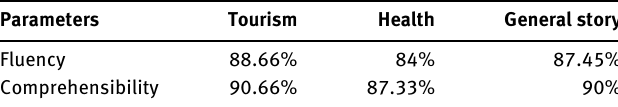
Table 9: Telugu-Tamil MT